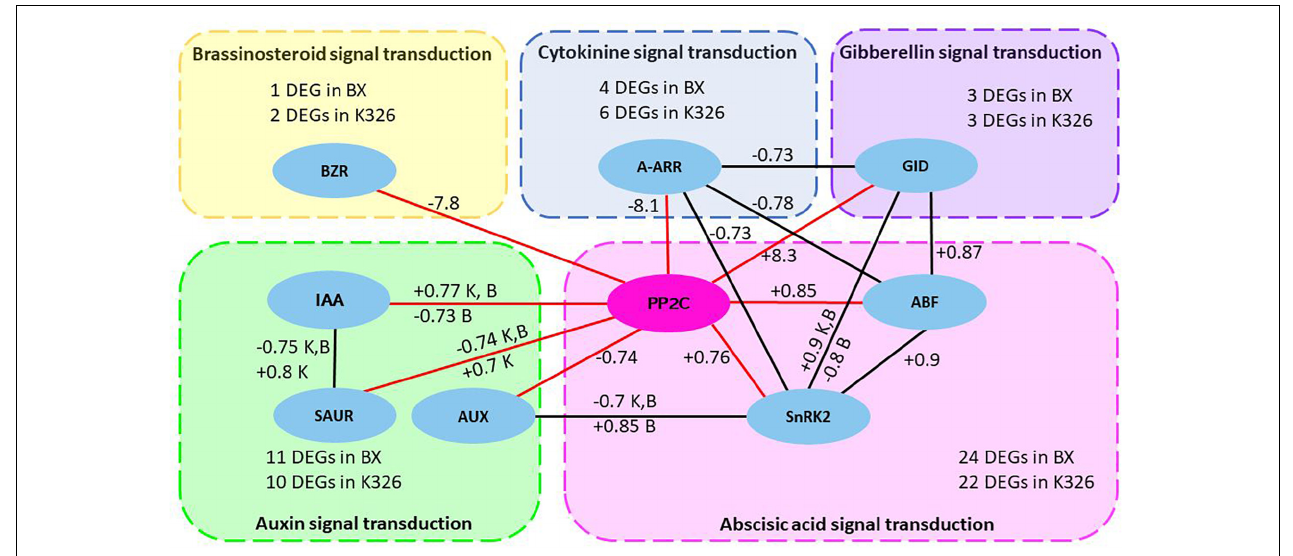
FIGURE 4 | Common regulatory network of hormone signaling pathways in response to drought between two Nicotiana